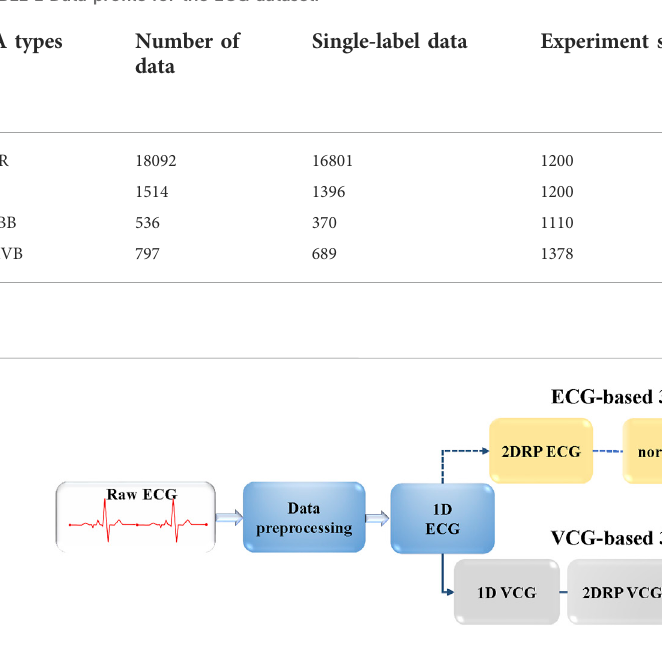
FIGURE 3 The fl ow chart of CA classi fi cation experiments.